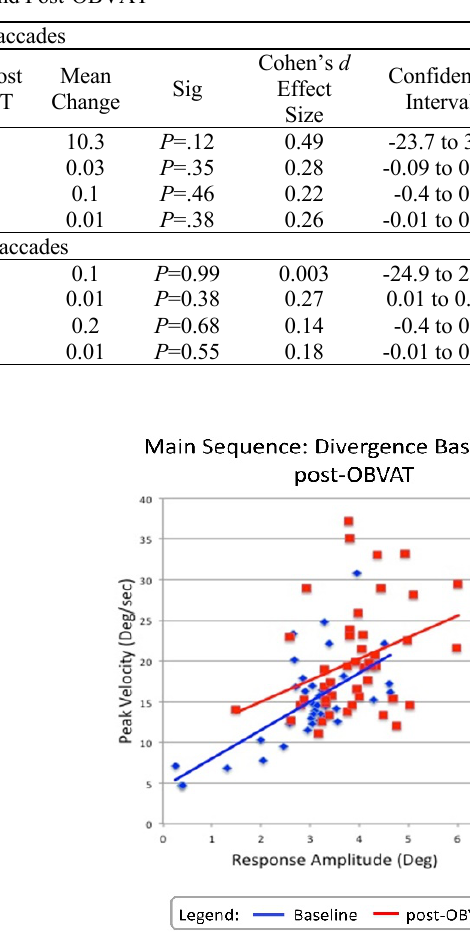
Figure 3: Main sequence for divergence pre- vs